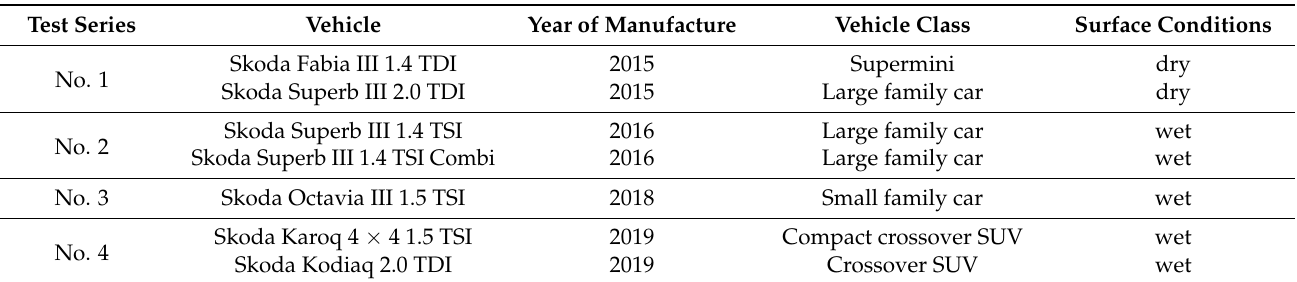
Table 2. Tested vehicles.